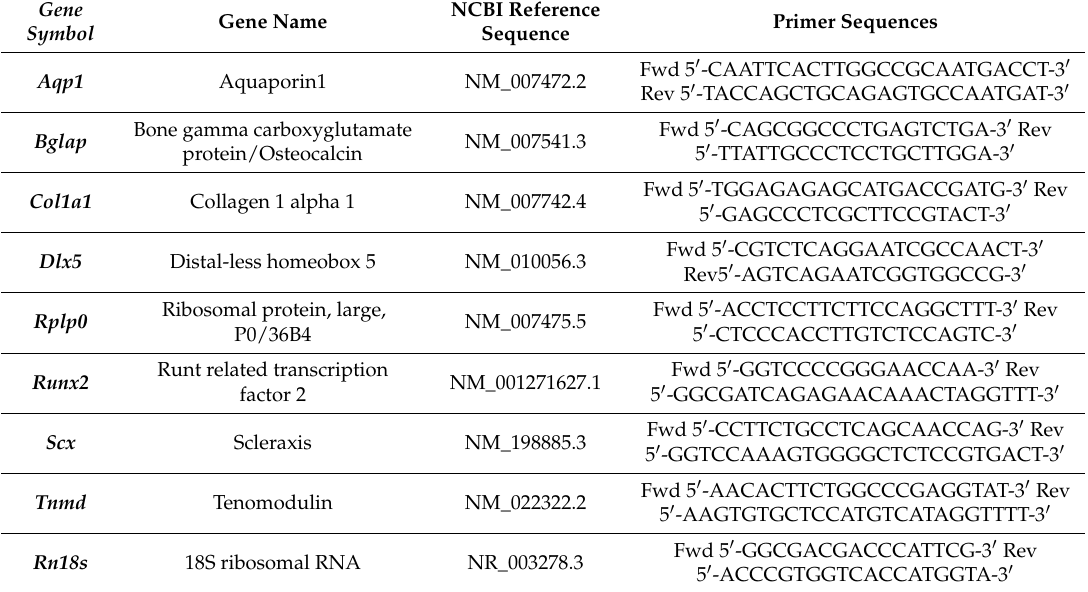
Table 3. Primer sequences used for the reverse transcription quantitative polymerase chain reaction (RT-qPCR) gene expression study on cultured electrospun